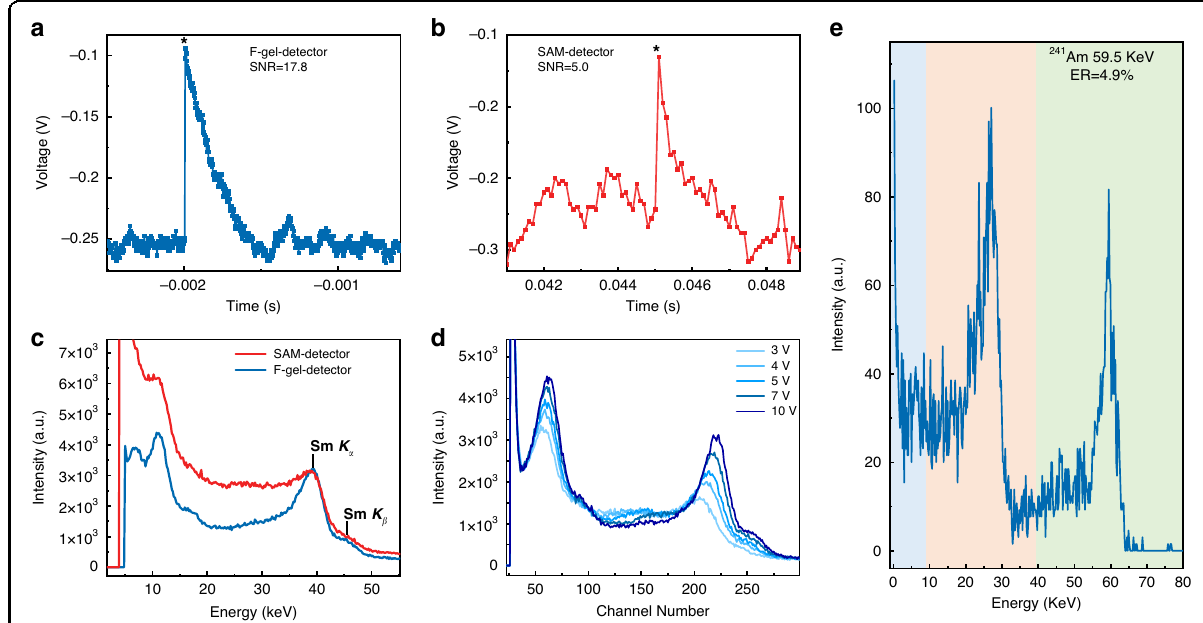
Fig. 6 Gamma-ray detection performance of the MAPbI 3 SC devices. The SNRs of a the F-gel-detector and b SAM-detector under 241 Am gamma rays. c The energy spectrum measurement with the SAM-detector and F-gel-detector under a 152 Eu gamma-ray source at room temperature. d The energy spectrum of the F-gel-detector with different bias voltages under a 152 Eu gamma-ray source. e The energy spectrum of the 241 Am source measured with the optimal